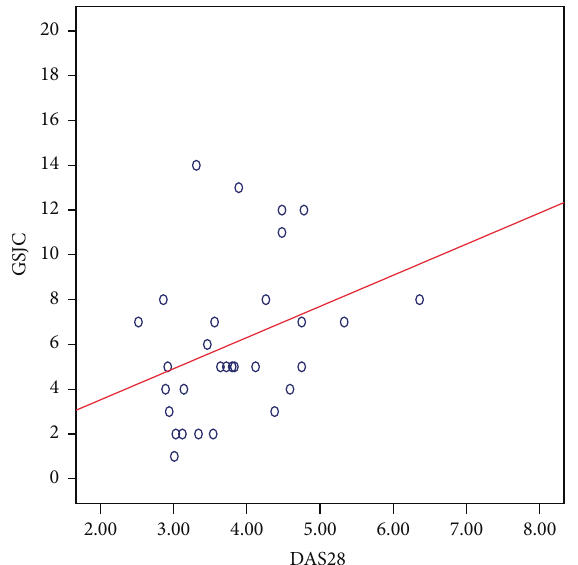
Figure 8: Relation between GSJC (taken from 28 MCP, PIP, and DIP joints)andTJCin30patientswithPsA.Spearman’s 𝜌 :0.474; 𝑃 :0.008 suggesting a significant